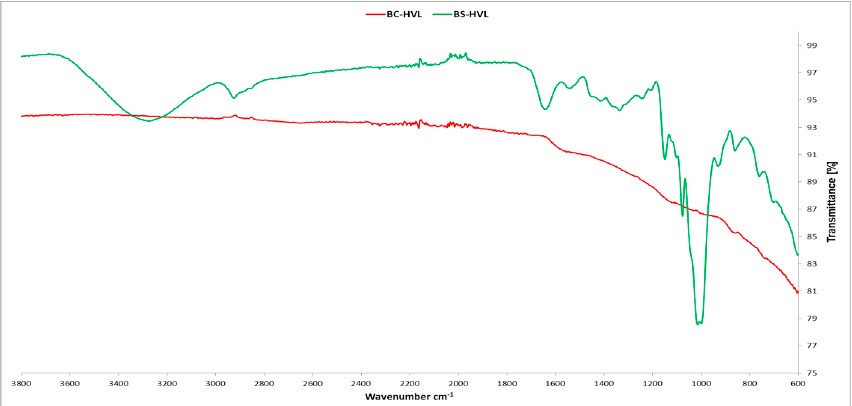
Figure 9. FTIR (fourier transform infrared spectroscopy) spectra of BS − HVL and BC − HVL.